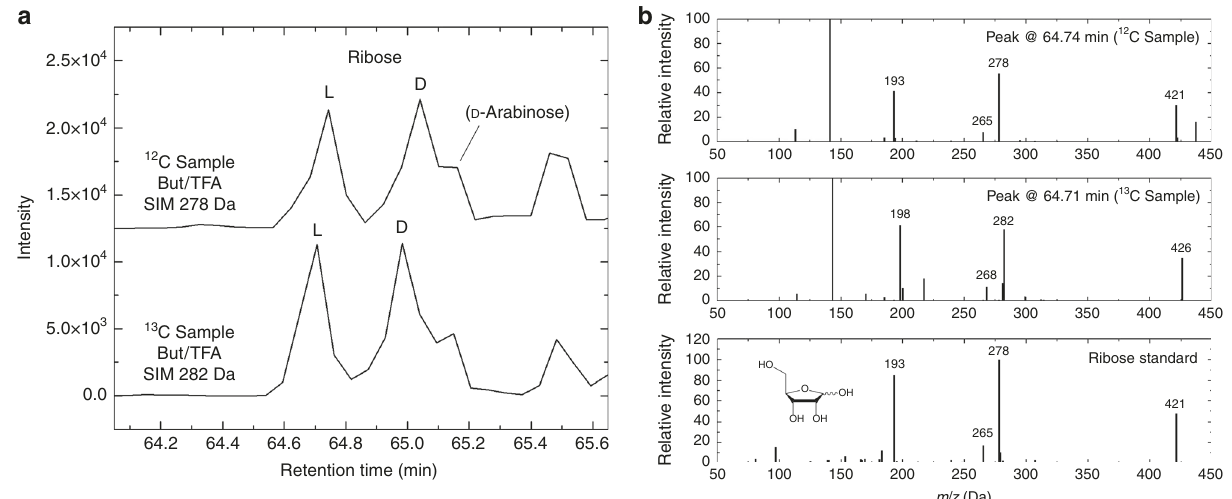
Fig. 3 Identi fi cation of ribose in ice photolysis residues. a SIM chromatograms of residues produced from the UV irradiation of H 2 O:CH 3 OH (2:1) ( 12 C sample, m / z = 278 Da) and H 2 O: 13 CH 3 OH (2:1) ( 13 C sample, 282 Da) ice mixtures after derivatization with ( + )-2-butanol/TFAA. Intensities are offset for clarity. b From top to bottom, mass spectra of the peaks assigned to L -ribose in the regular residue, the 13 C-labeled residue, and a standard of ribose. The molecular structure of ribose is shown without derivatization. Assignments of the fragments in the mass spectra can be found in Supplementary Table